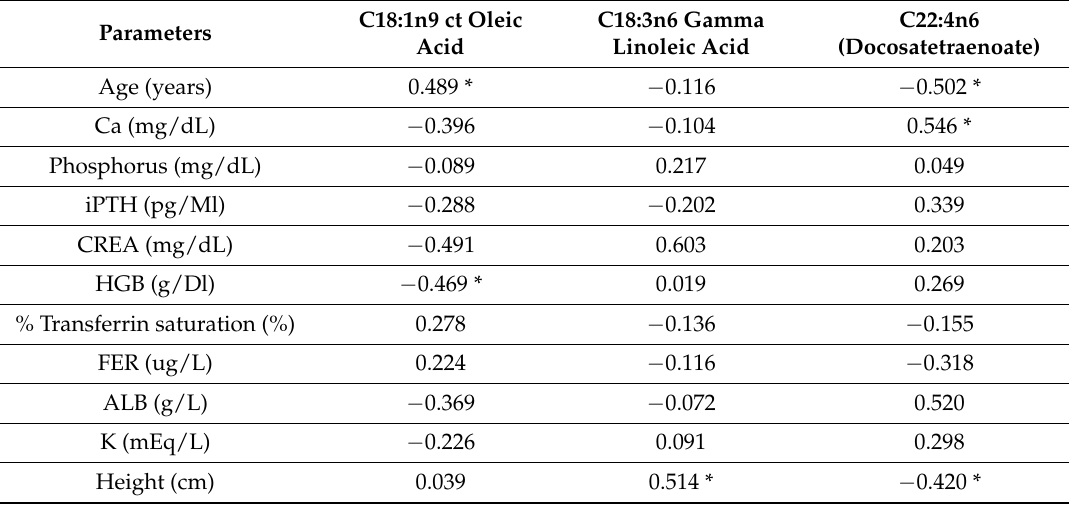
Table 4. Correlation matrix for selected FA with parameters of CKD patients. iPTH: parathyroid hormone. CREA: creatinine. HGB: hemoglobin. FER: ferritin. ALB: albumin. Kt/V: dialysis